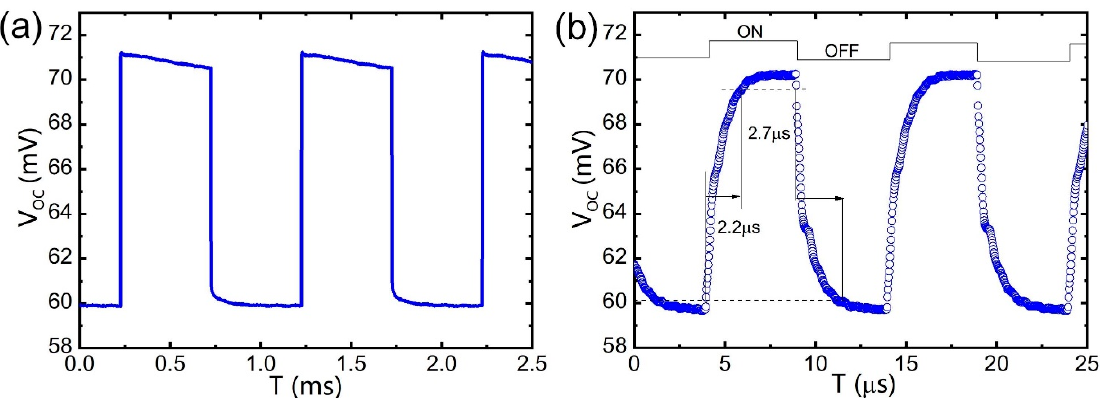
Figure 5. ( a ) Response time of the GNEC film/n-Si photodetector under 1 kHz square wave optical signal. ( b ) Response time of the GNEC film/n-Si photodetector under 100 kHz square wave optical signal. High sensitivity is demonstrated, the ON/OFF response rise time is 2.2 μ s, and the recovery time is 2.7 μ s.